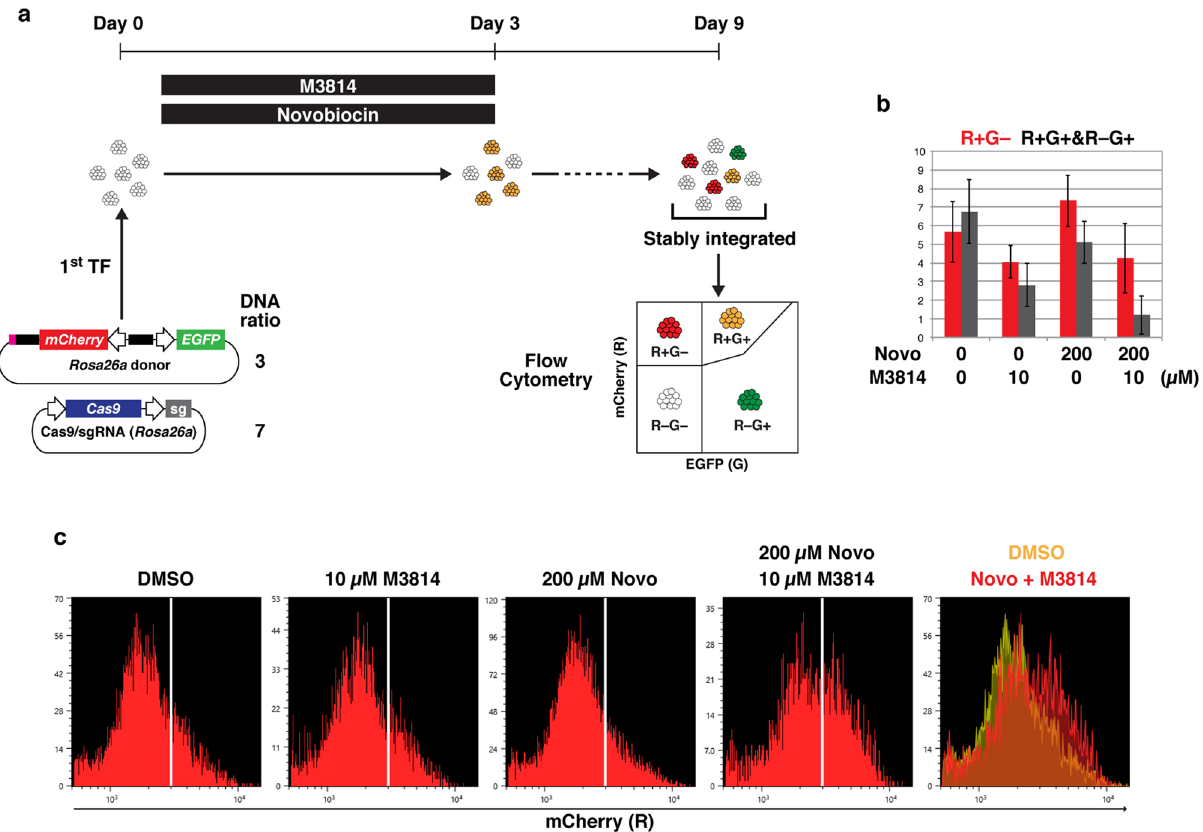
Figure 6. Effects of novobiocin and M3814 on HDR-mediated knock-in into Rosa26a . ( a ) Experimental scheme. Weight ratio of donor DNA and Cas9/sgRNA expression vector is shown. ( b ) Flow cytometry analysis of mESCs transfected with the Rosa26a donor and Cas9/sgRNA expression vector. A series of experiments, from transfection to flow cytometric analysis, was independently performed in triplicate. The average ± standard deviation percentages of R+G− (red) and R+G+ and R−G+ (gray) cells are shown in the bar graph. ( c ) Fluorescence intensities of mCherry of R+G− populations in the experiments shown in Fig. 6b. Representative histograms from three independent experiments are